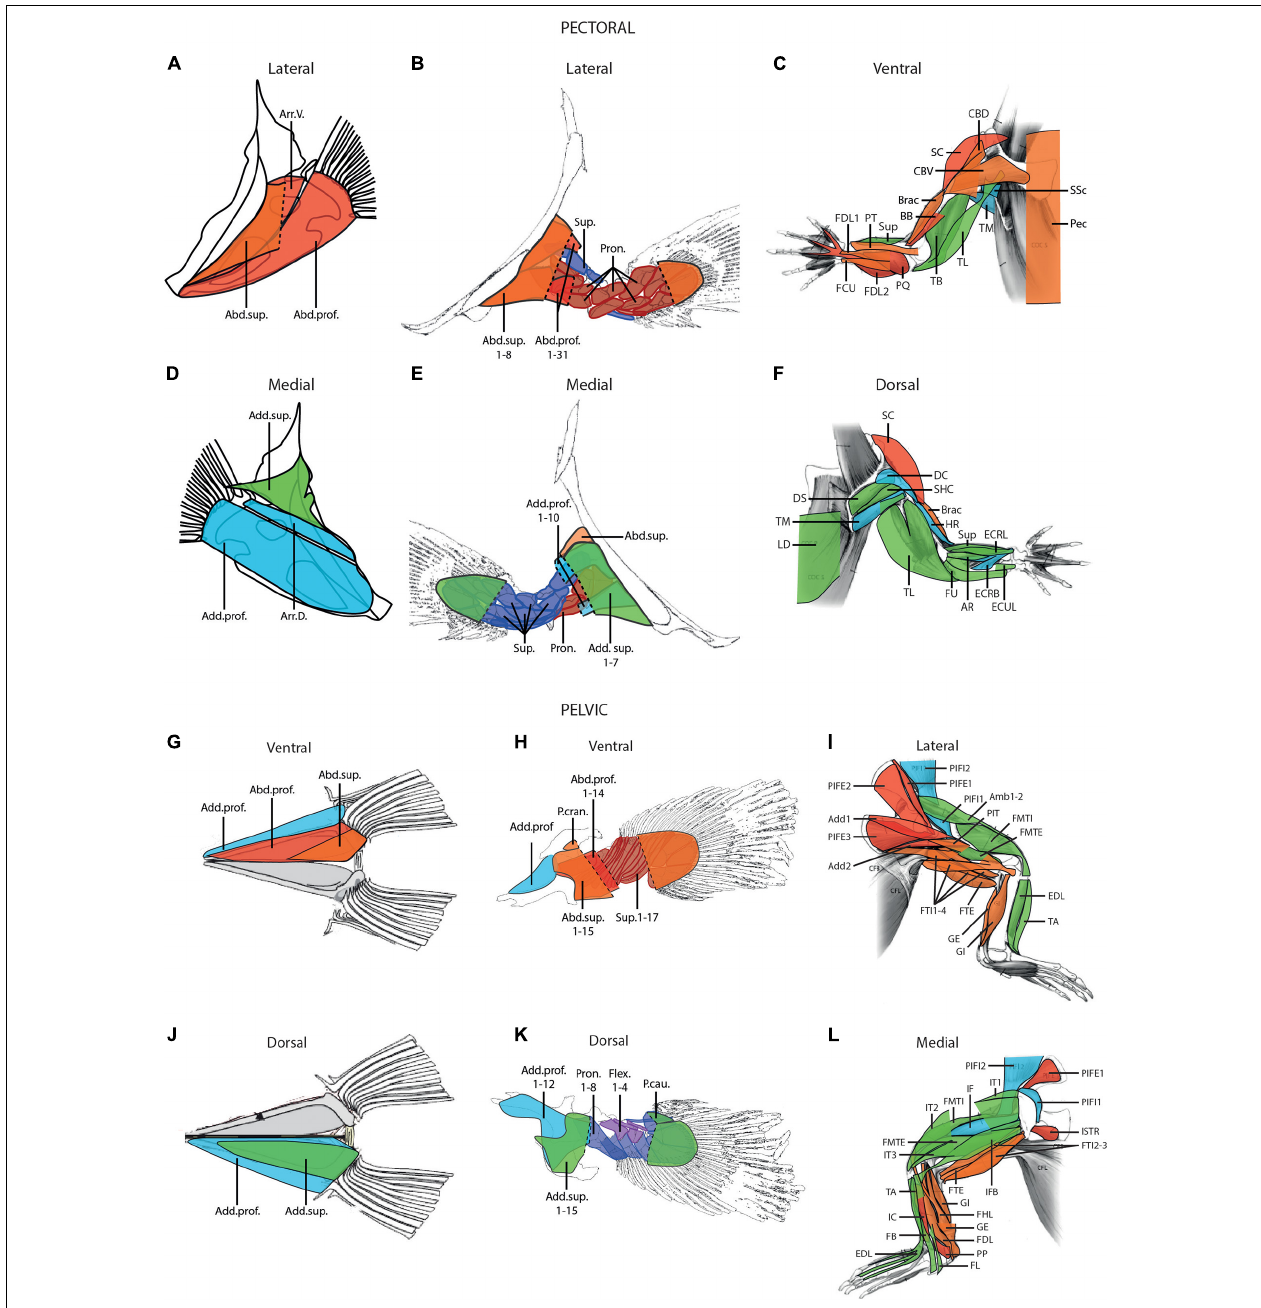
FIGURE 1 | Hypotheses of homology of the muscles of the pectoral (A–F) and pelvic (G–L) appendages in fish (A,D,G,J) , the coelacanth, Latimeria (B,E,H,K) , and the alligator (C,F,I,L) ; modified from Thorsen and Westneat (2005), Allen et al. (2010), and Huby et al. (2021). Blue, adductor profundus group; green, a dductor superficialis group; orange, abductor superficialis group; red, abductor profundus group. Note that for the coelacanth Latimeria (B,E,H,K) the profundus groups are separated in two different layers. Abd.prof., abductor profundus ; Abd.sup., abductor superficialis ; Add.prof., adductor profundus ; Add.sup., adductor superficialis ; Add, adductor ; Amb, ambiens ; Arr.D., arrector dorsalis ; Arr.V., arrector ventralis ; AR, abductor radialis ; BB, biceps brachii ; Brac, brachialis ; CBD, coracobrachialis dorsalis ; CBV, coracobrachialis ventralis ; DC, deltoideus clavicularis ; DS, deltoideus scapularis ; ECRB, extensor carpi radialis brevis ; ECRL, extensor carpi radialis longus ; ECUL, extensor carpi ulnaris longus ; EDL, extensor digitorum longus ; FB, fibularis brevis ; FCU, flexor carpi ulnaris ; FDL, flexor digitorum longus ; FHL, flexor hallucis longus ; FL, fibularis longus ; FMTE, femorotibialis externus ; FMTI, femorotibialis internus ; FTE, flexor tibialis externus ; FTI, flexor tibialis internus ; FU, flexor ulnaris ; GE, gastrocnemius externus ; GI, gastrocnemius internus ; HR, humeroradialis ; IC, interosseus cruris ; IF, iliofemoralis ; IFB, iliofibularis ; ISTR, ischiotrochantericus ; IT, iliotibialis ; LD, latissimus dorsi ; Pec, pectoralis ; PIFE, puboischiofemoralis externus ; PIFI, puboischiofemoralis internus ; PIT, puboischiotibialis ; PP, pronator profundus ; PQ, pronator quadratus ; Pron., pronator ; PT, pronator teres ; SC, supracoracoideus ; SHC, scapulohumeralis caudalis ; SSc, subscapularis ; Sup, supinator ; TA, tibialis anterior ; TB, triceps brevis ; TL, triceps longus ; TM, teres major .